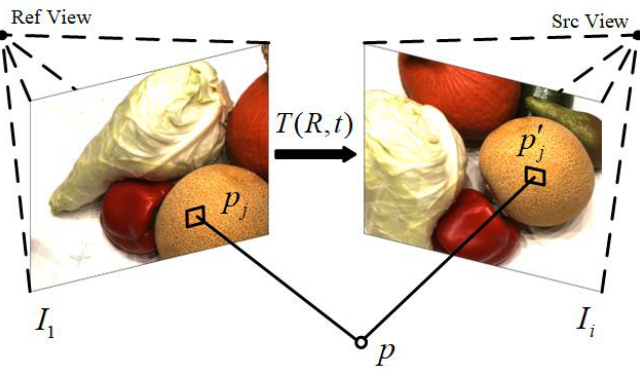
Figure 2. Principle of photometric consistency loss.